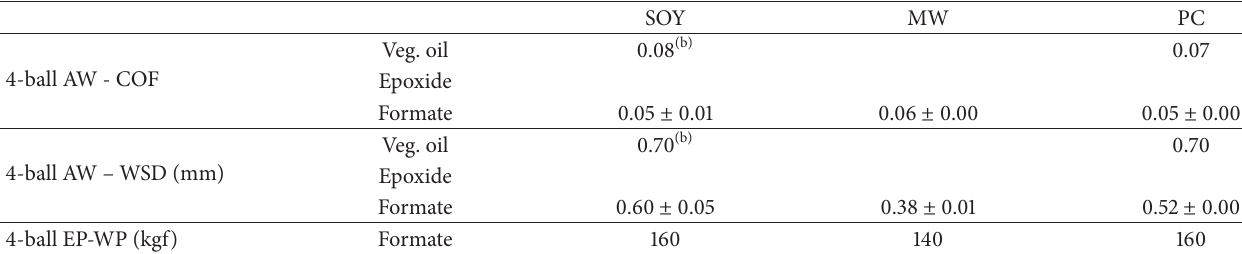
Table 4: Tribological properties of vegetable oils, epoxides, and formate esters ( a ) . SOY